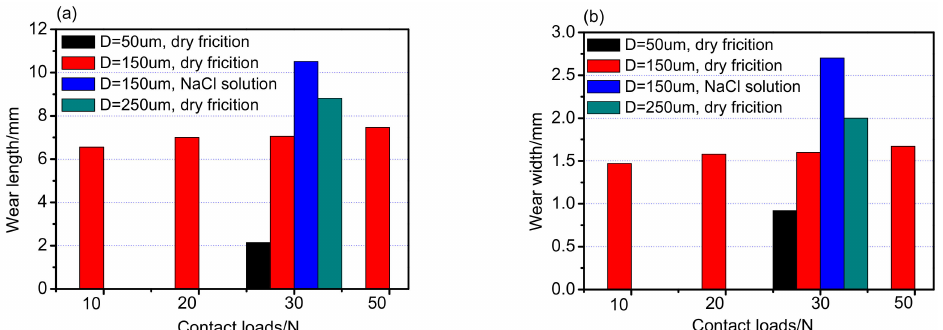
Figure 6. ( a ) The length and ( b ) width of contact scar of the fretted wires.